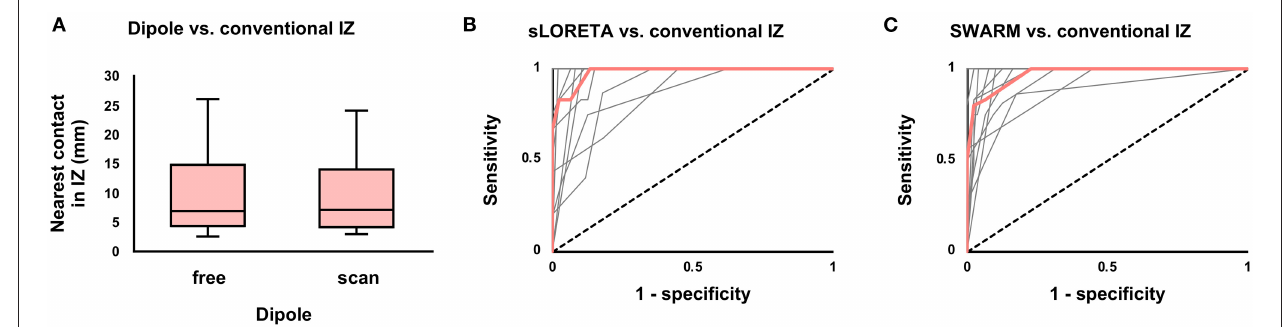
FIGURE 1 | Agreement between the conventional and modeled irritative zones (IZ) among seizure-free patients. (A) Boxplot of distance from dipole to nearest contact showing interictal activity. There was no difference ( P = 0.66) between free and scan dipole solutions. (B) Receiver-operating characteristic (ROC) curve for concordance of the conventional IZ with the sLORETA-modeled IZ (volume of above-cutoff current density). Median (thick red line) and individual patient curves (thin gray lines) are shown. (C) Similar ROC curve for SWARM.